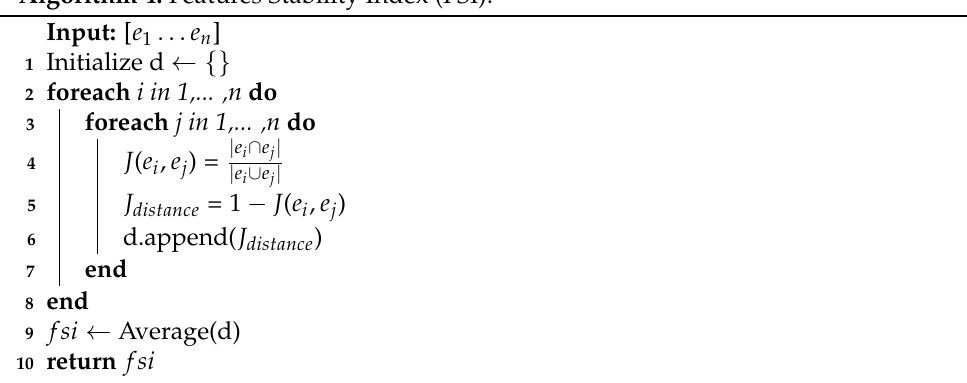
Algorithm 4: Features Stability Index